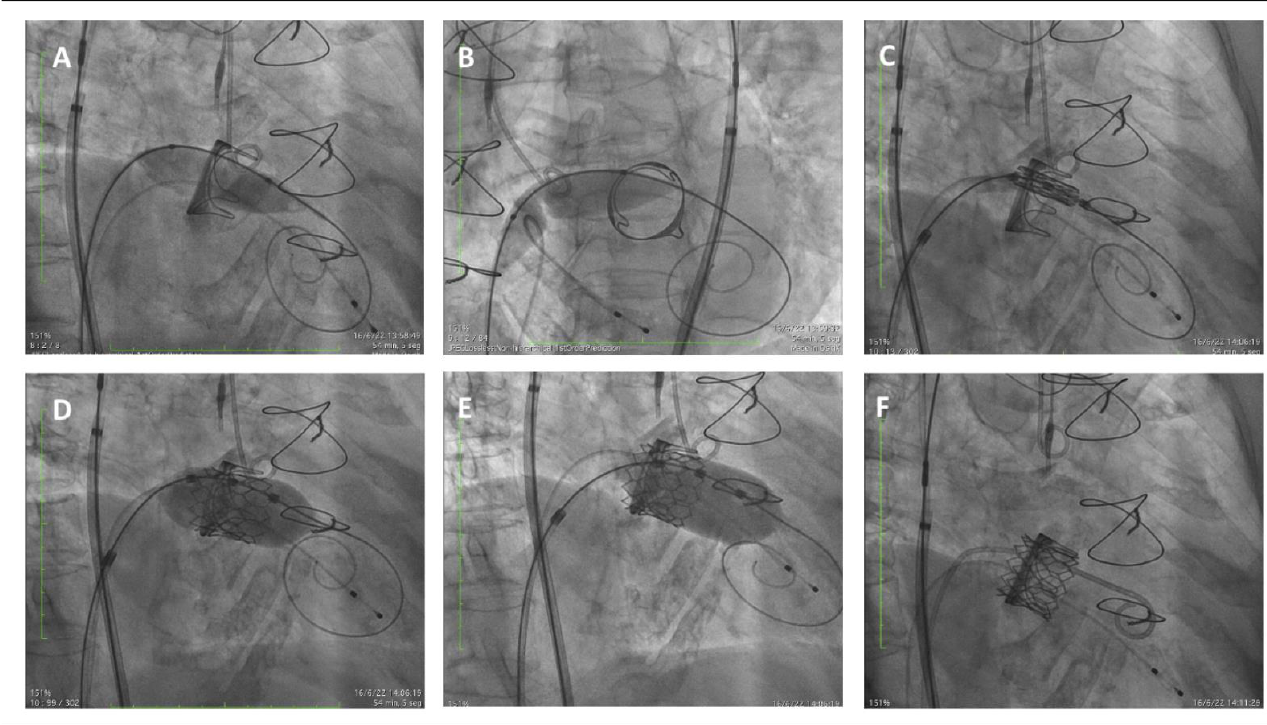
Figure 1. Step-by-step mitral valve-in-valve procedure, fluoroscopic images. ( A ) Balloon valvulo- plasty with a 14 mm balloon over the Safari wire advanced through the interatrial septum and across the surgical mitral bioprosthetic valve. ( B ) Balloon dilation of the interatrial septum with the same 14 mm balloon. ( C ) Positioning of the transcatheter Myval device within the surgical bioprosthetic frame. ( D ) Deployment of the transcatheter valve inside the previous surgical bioprosthetic mitral valve. ( E ) Postdilatation with the same balloon slightly advanced towards the left ventricle aiming to provide a flail and preclude from atrial migration. ( F ) Final result.